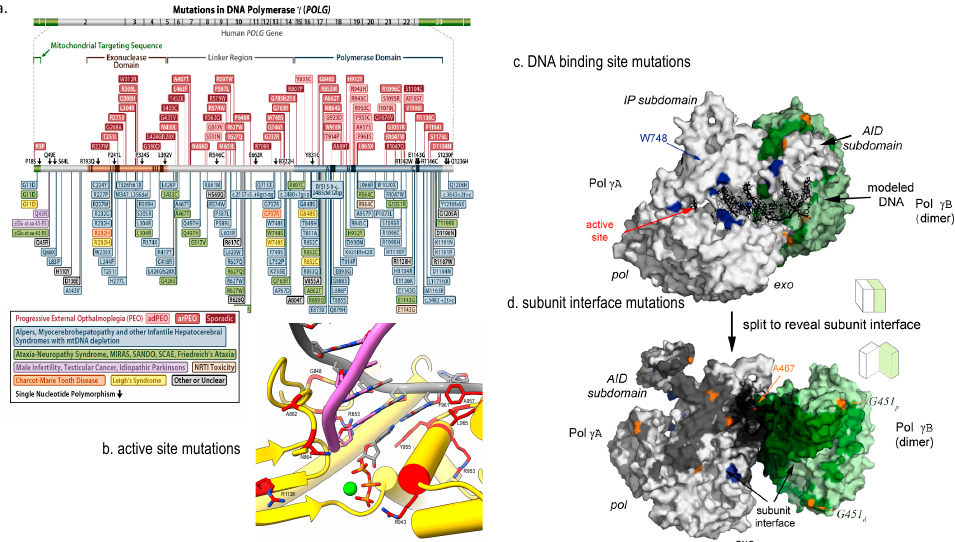
Figure 4. Structural view of Pol γ mutations. ( a ) disease-associated mutations depicted on a linear sequence of Pol γ A (adopted from https://tools.niehs.nih.gov/polg/_assets/images/POLG_mutation.png (accessed on 10 December 2022), ( b ) mutations in Pol γ A active site, ( c ) mutations in DNA binding sites, and ( d ) mutations in subunit interface, where Pol γ A is colored white, proximal and distal Pol γ B in green and light green, respectively, and DNA in black adopted from [82]. © 2009 Elsevier Inc. Published by Elsevier Inc.